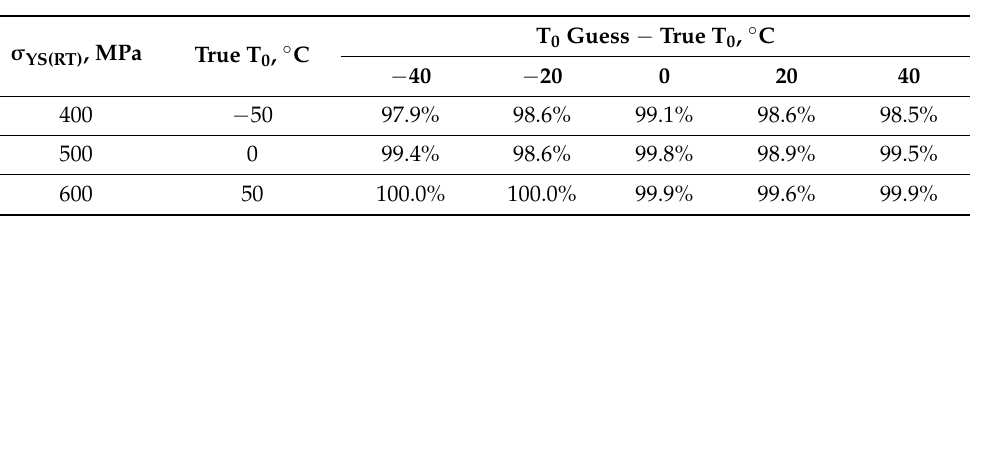
Table 1. Influence of error in initial T 0 guess on the success rate of valid T 0 evaluation with N=12 or fewer specimens